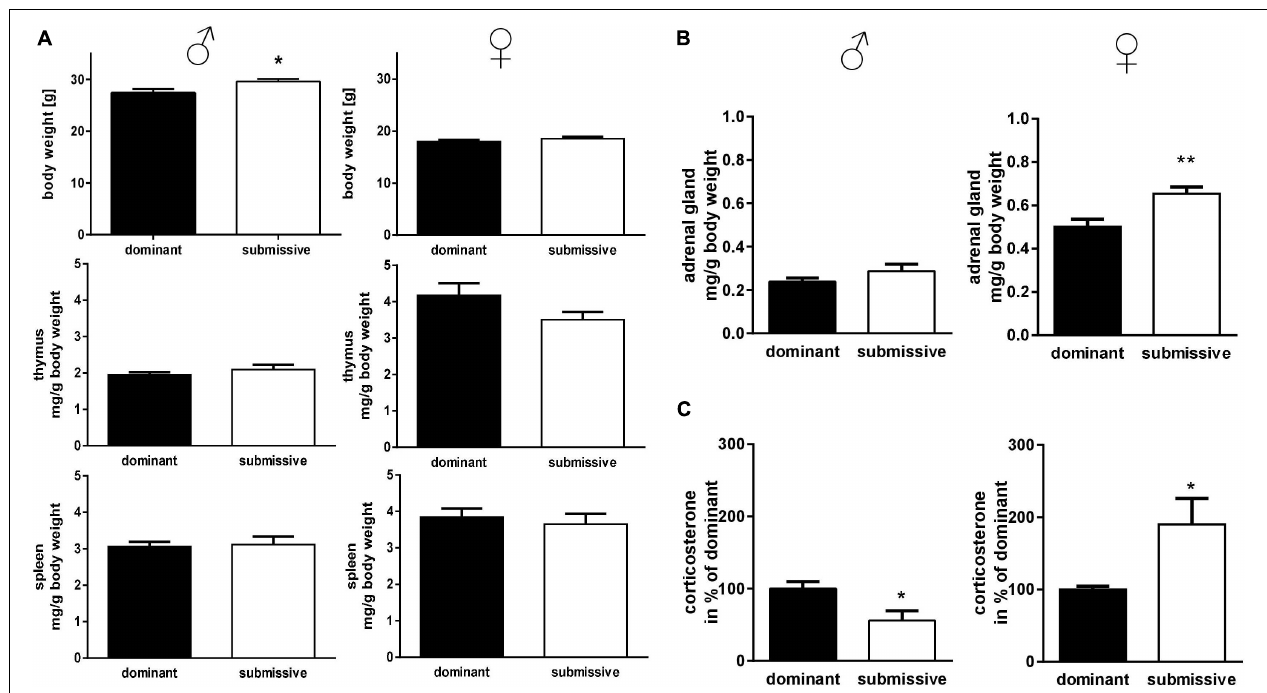
FIGURE 2 | Physical parameters in accordance with social status. Body weights of mice identified as dominant or submissive as well as thymus and spleen weights were assessed (A) . Adrenal glands were weighed (sum of both glands) (B) and CORT concentration of serum samples was measured by HPLC analysis (C) . Data are presented as mean + SEM. Statistical analysis was performed with unpaired Student’s t -test. Sample size was ( n = 7) per group except for dominant female spleen weight ( n = 6) and adrenal gland weight of submissive males ( n = 6). The lacking data points were removed due to incomplete dissection and thereby non-plausible tissue weight. Statistical analysis was performed with unpaired Student’s t -test (** p < 0.01; * p <